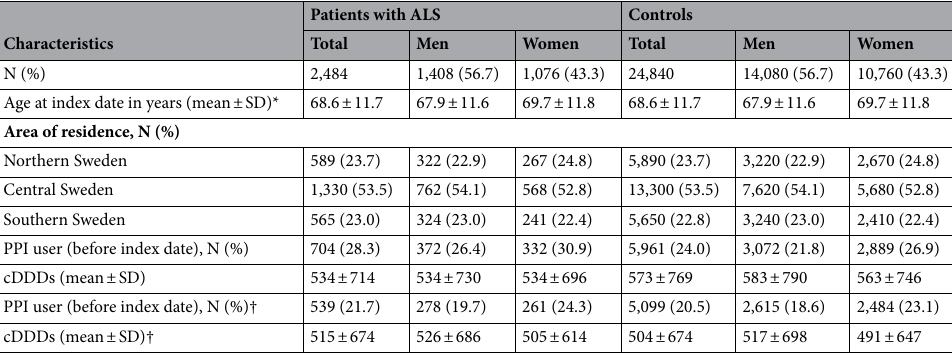
Table 1. Characteristics of ALS patients and the matched controls, a nested case–control study in Sweden, 2006–2013. SD standard deviation, cDDDs cumulative defined daily doses. *Date of diagnosis for ALS patients and date of selection for controls. † After inclusion of a lag window of 1